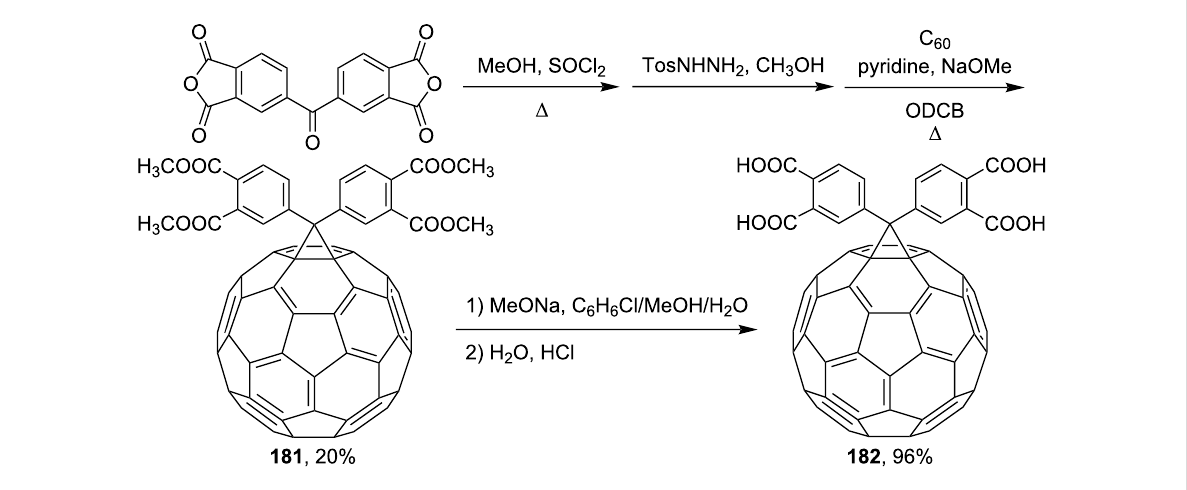
Scheme 31: The synthetic route to water-soluble methano[60]fullerene-appended tetracarboxylic acid derivatives.